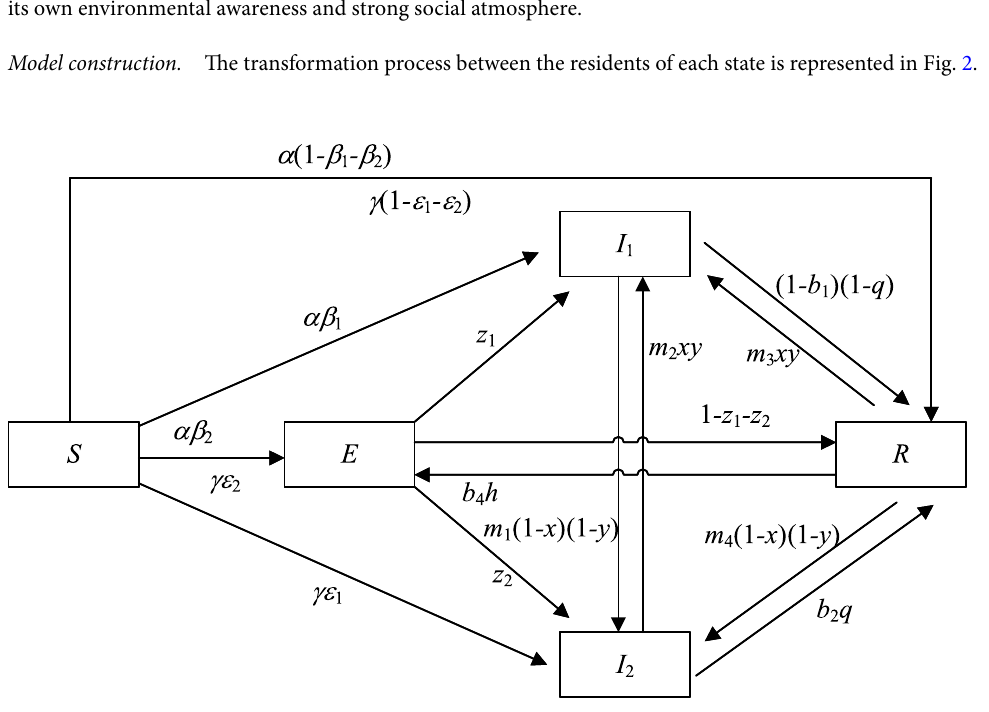
Figure 2. The SEIR dissemination model of residents’